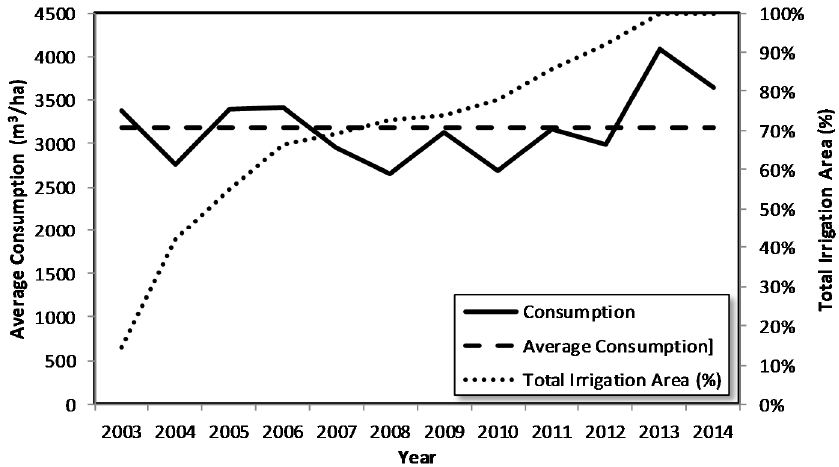
Figure 6. Measured Annual Consumption in Vallada case study network.